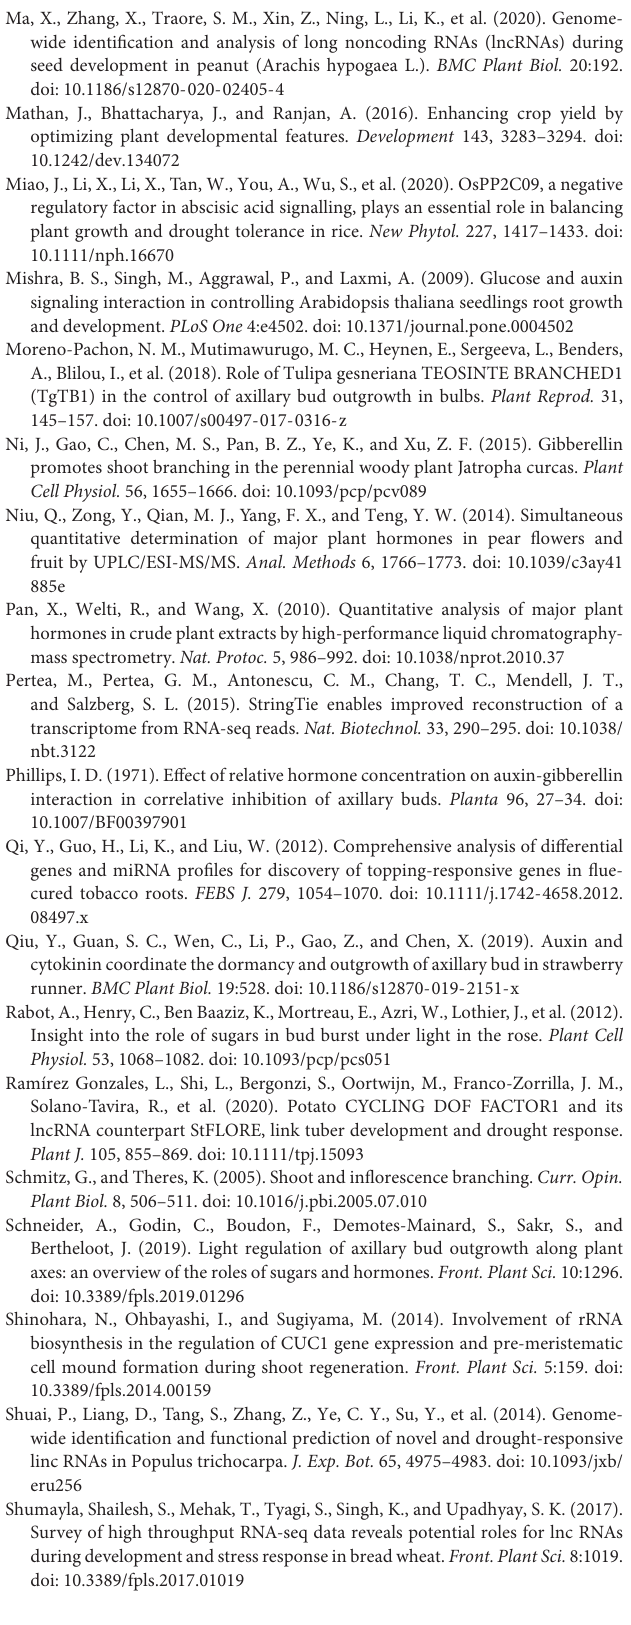
Frontiers in Plant Science |